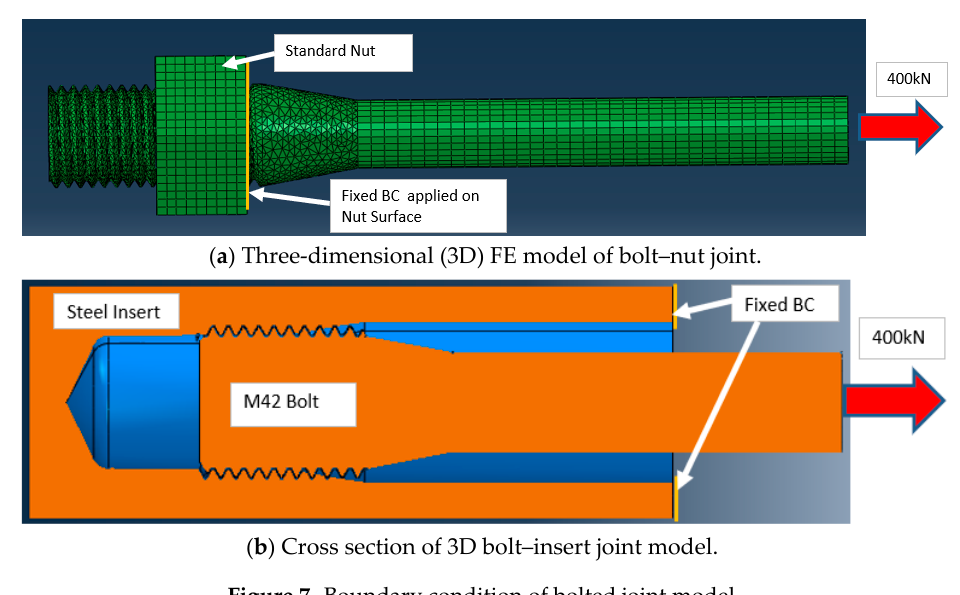
Figure 6. Blade coordinate system; XB in direction of the rotor axis, ZB in radial direction along the blade, and YB in direction of the cross product of ZB and XB [4].